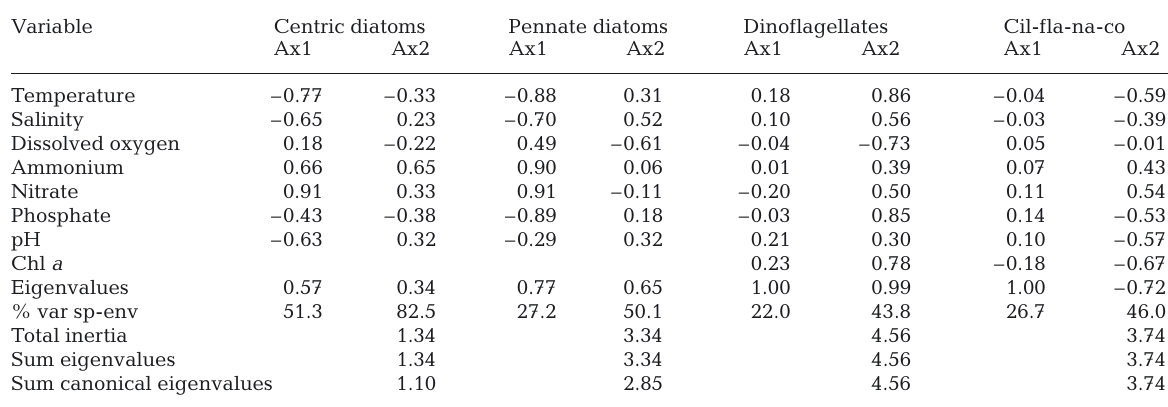
Table 4. Summary for the 2 axes (Ax1 and Ax2) of canonical correspondence analysis with 8 selected environmental factors. % var sp-env: cumulative percentage variance of species−environment relation; eigenvalues: sum of eigenvalues and